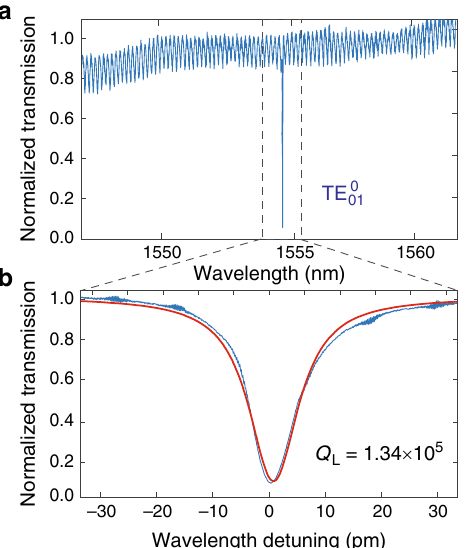
Fig. 4 Linear optical property of a fabricated LN photonic-crystal EOM. a Laser-scanned transmission spectrum in the telecom band. b Detailed transmission spectrum of the fundamental TE-like cavity mode TE 0 wavelength of 1554.47 nm, with the experimental data shown in blue and the theoretical fi tting shown in red.